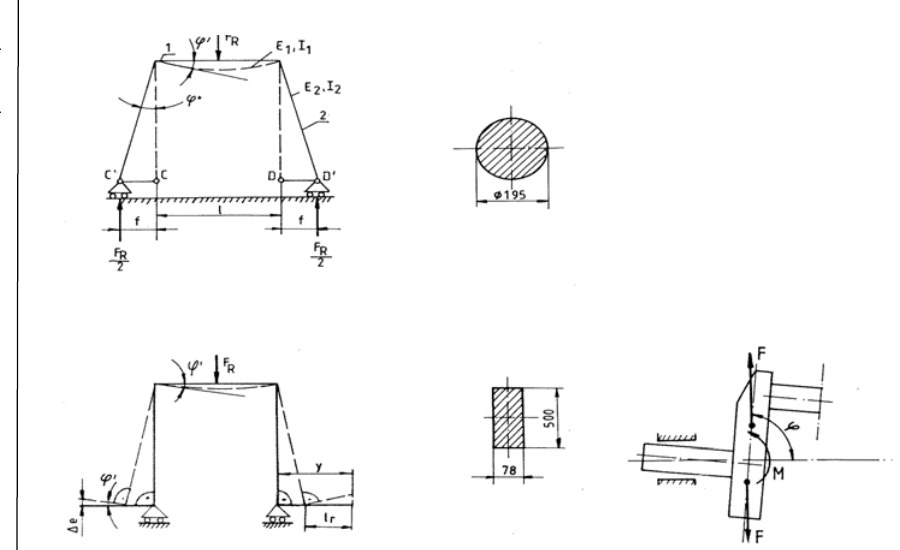
Figure 13 – Deformations of the engine crankshaft and the influence of additional inertial